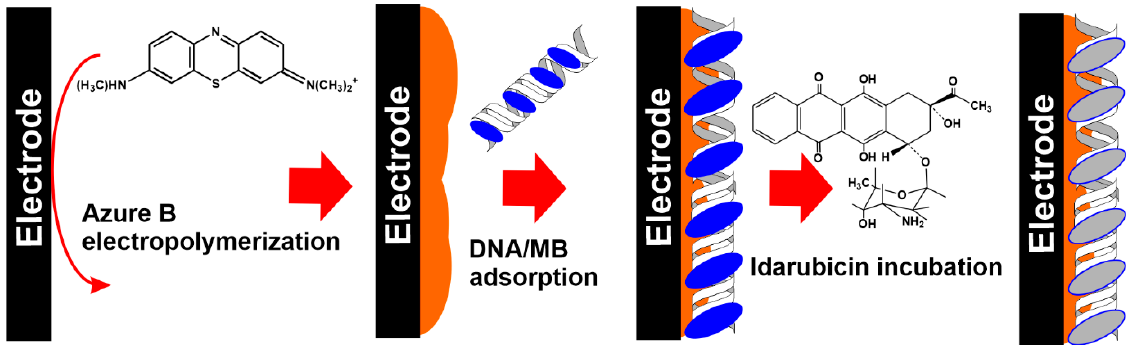
Figure 1. Schematic outline of DNA sensor assembling and idarubicin determination.